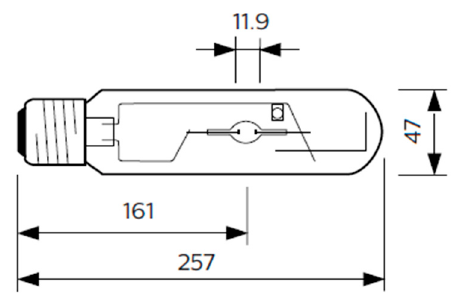
Figure 1. Metal halide lamp structure (mm).